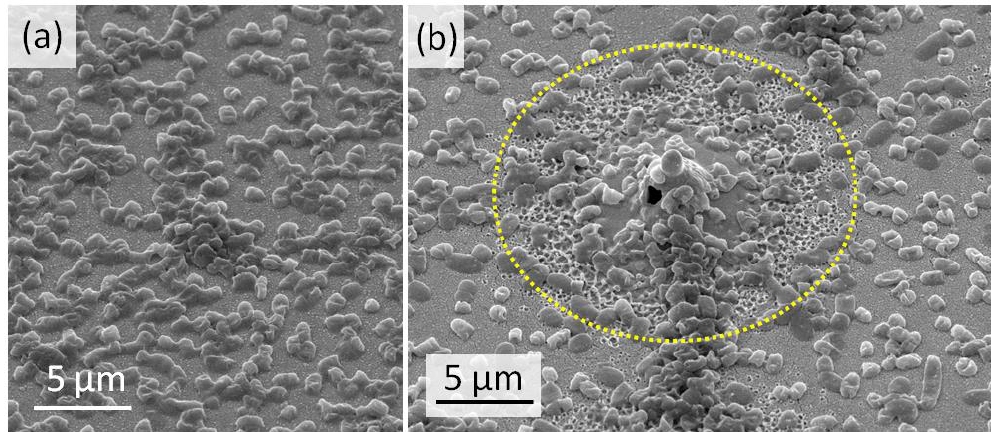
Figure 4. SEM images of S. aureus bacteria on the unstructured Au film ( a ) and on Au nanospikes ( b ).